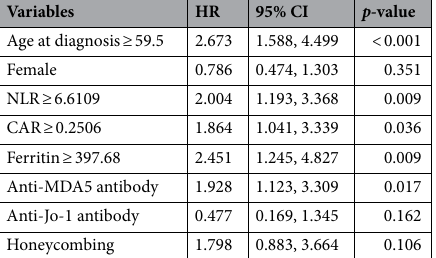
Table 4. Results of multivariable Cox regression analyses for mortality IIM-ILD. NLR, neutrophil-to- lymphocyte ratio; CAR, C-reactive protein to albumin ratio.